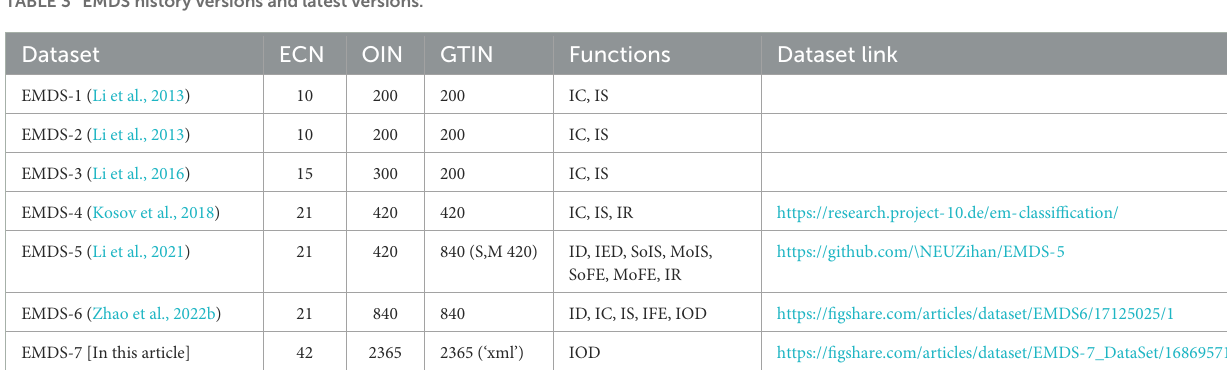
TABLE 3 EMDS history versions and latest